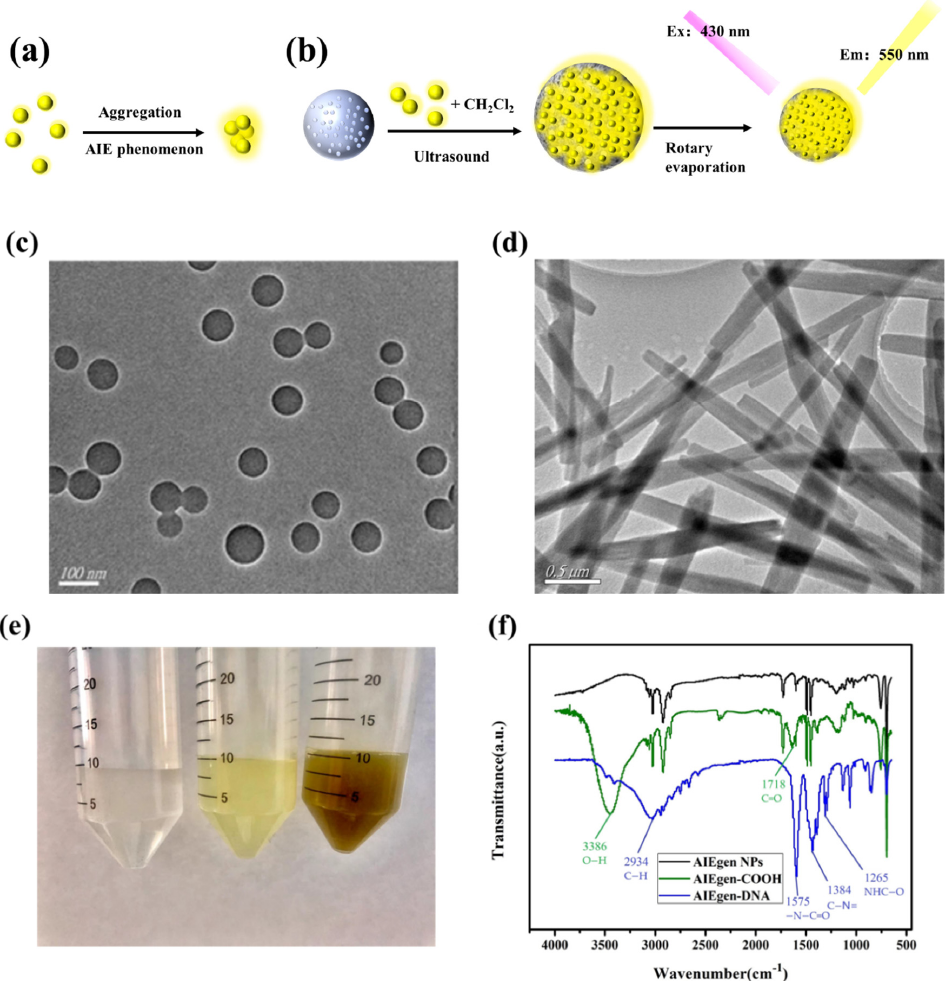
Figure 2. ( a ) The AIEgen principle (Left: no fluorescence without DSAI aggregation; high fluorescence with DSAI aggregation). ( b ) Synthesis of AIEgen nanospheres; ( c ) TEM image of AIEgen NPs; ( d ) TEM image of MOF; ( e ) Results of tea treated by three methods; ( f ) FT-IR spectra of AIEgen NPs modified with carboxyl functionalisation and DNA.